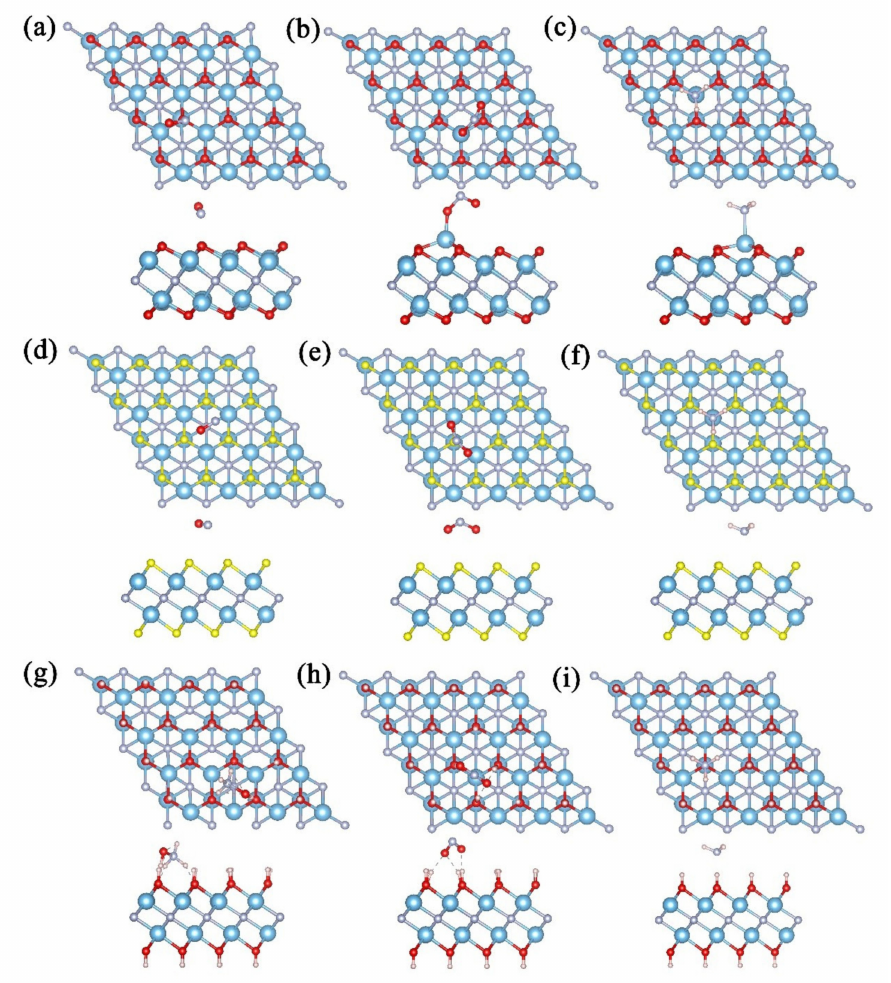
Figure 5. Top and side view of the optimized structures for Ti 2 NO 2 after adsorbing ( a ) NO, ( b ) NO 2 , and ( c ) NH 3 ; Ti 2 NF 2 after adsorbing ( d ) NO, ( e ) NO 2 , and ( f ) NH 3 ;and Ti 2 N(OH) 2 after adsorbing ( g ) NO, ( h ) NO 2 , and ( i ) NH 3 (blue, silver, red, pink, and yellow balls represent Ti, N, O, H, and F atoms,